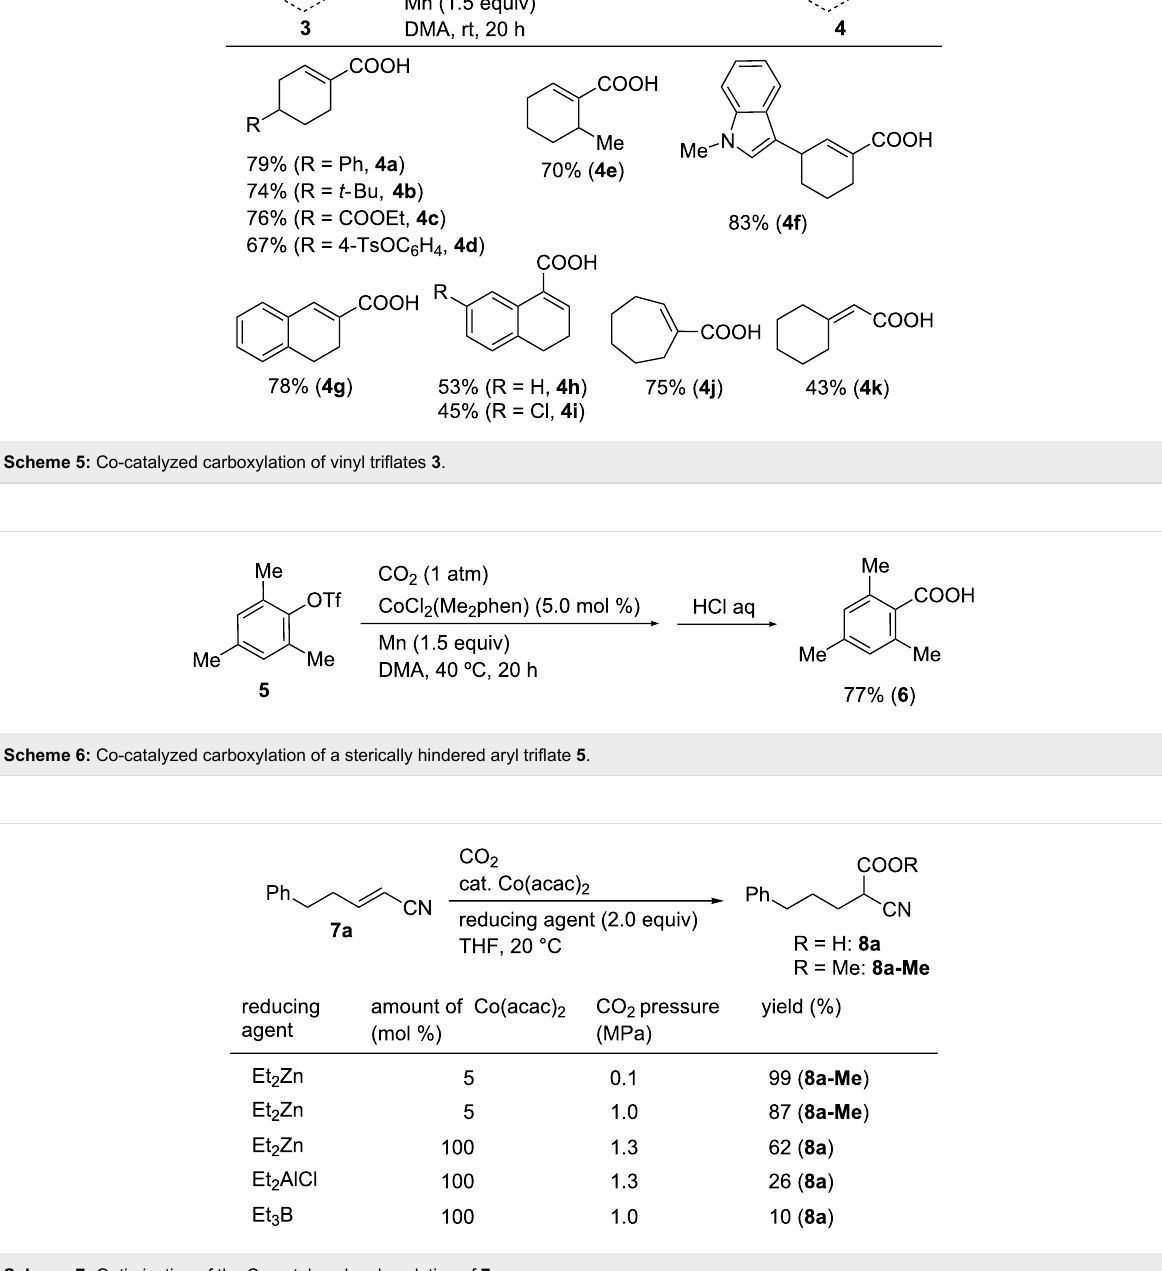
Scheme 7: Optimization of the Co-catalyzed carboxylation of 7a